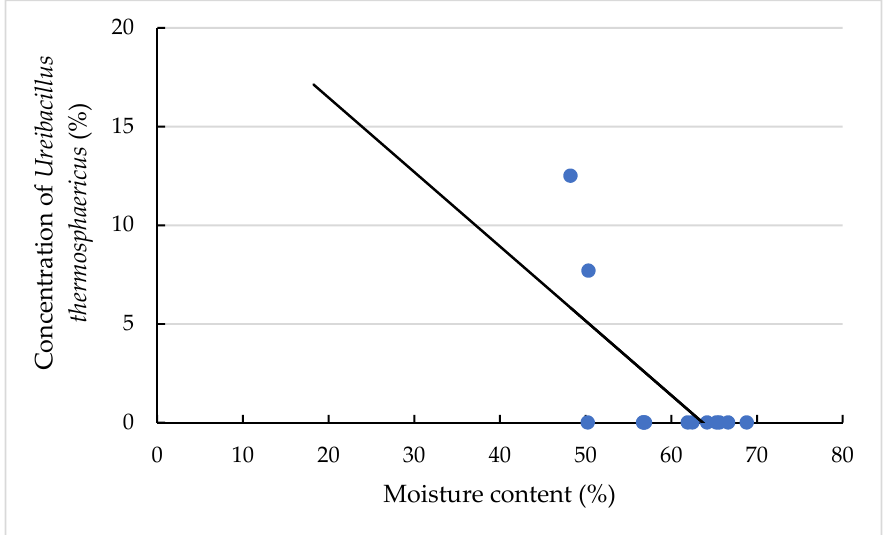
Figure 6. Concentration of Ureibacillus thermophaericus (%) in dependency of moisture content. The individual dots reflect the individual samples, and the black line is the regression line calculated with the equation written as: y = − 0.38x + 24.01 and a coefficient of determination of 0.38. Furthermore, the relative humidities at the heights of 0.10 m (Figure 7) and 1.30 m above the bedding material had a significant ( p < 0.05) effect on Laceyella sacchari concentration, explaining its absence in summer season, for example, when the relative humidity seemed to be too low for the growth of this TAS species.